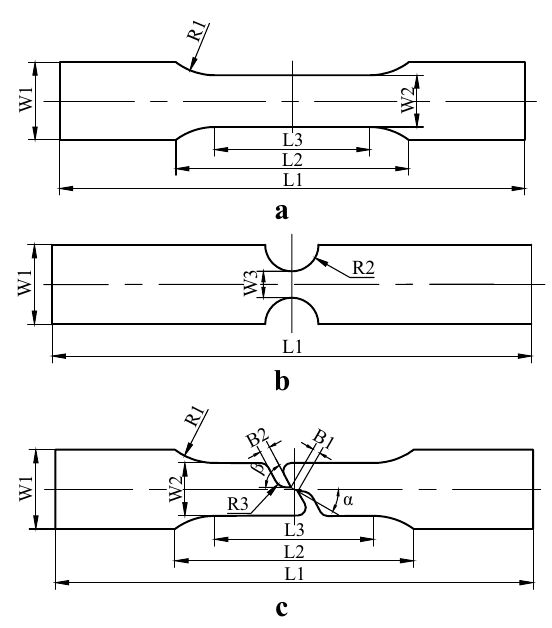
Figure 1 Shapes of specimens: a standard tensile specimen, b specimen with arc–shaped notches and c specimen with sharp– angled